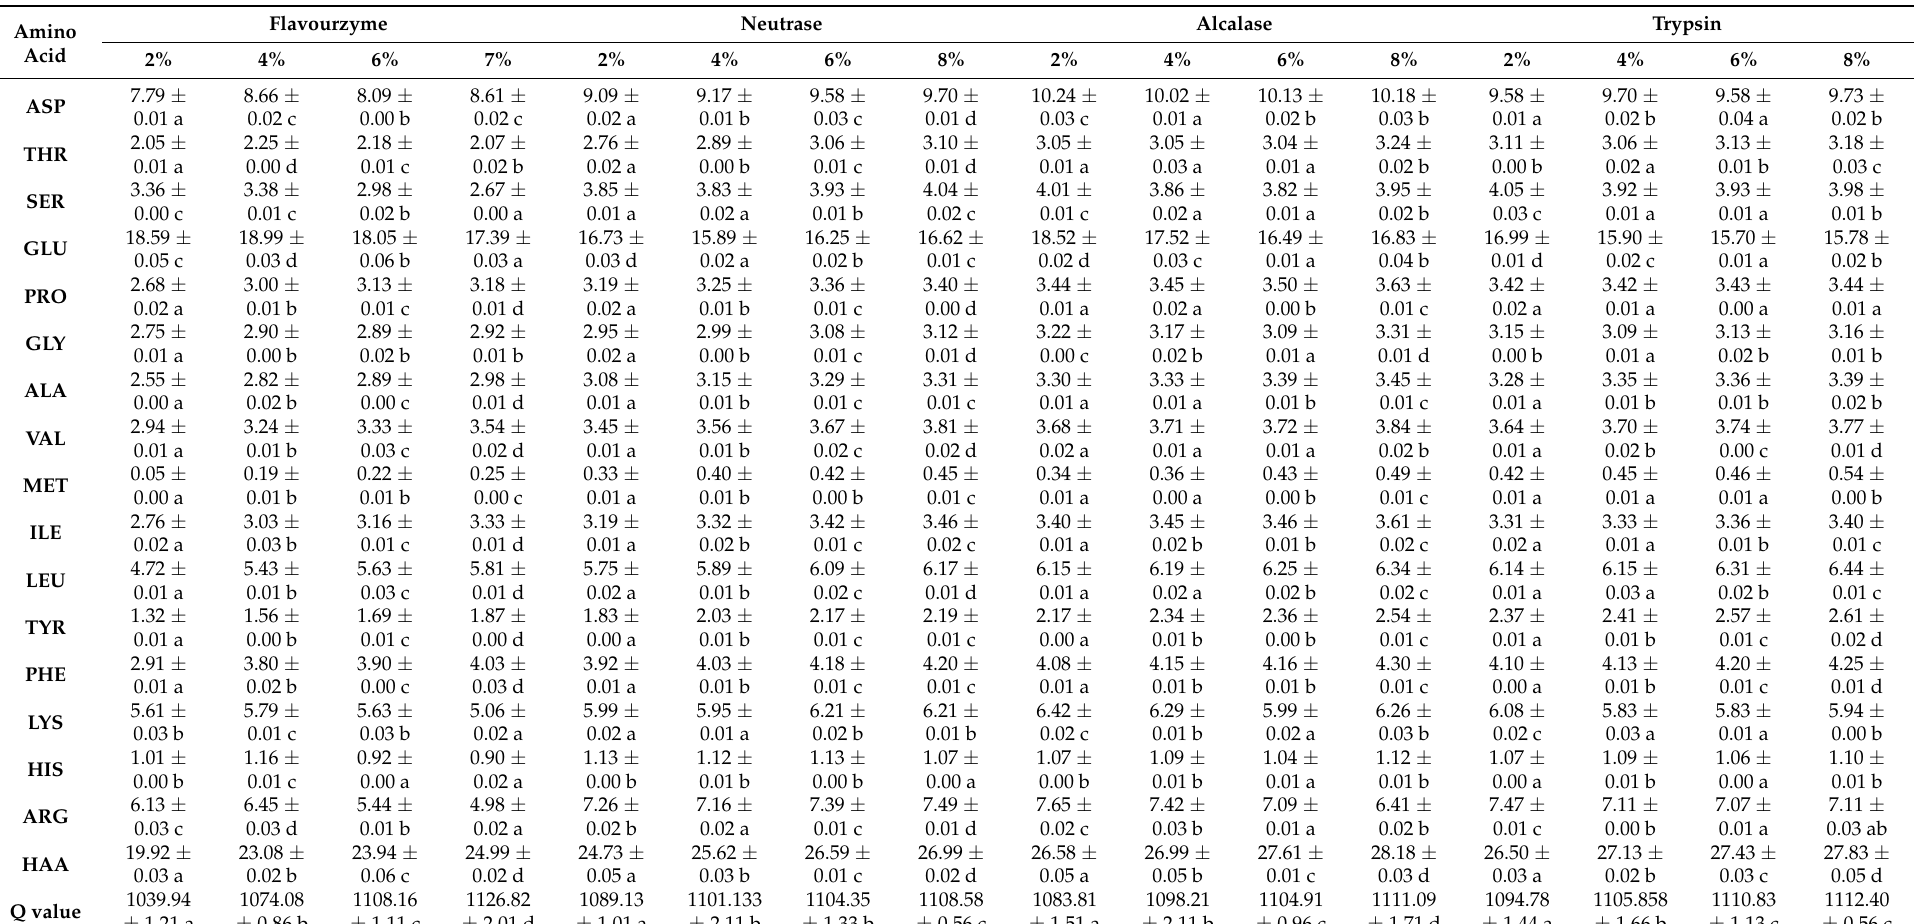
Table 2. Amino acid composition of PP with different DH samples treated with flavourzyme, neutrase, alcalase, and trypsin (g/100 g). HAA: hydrophobic amino